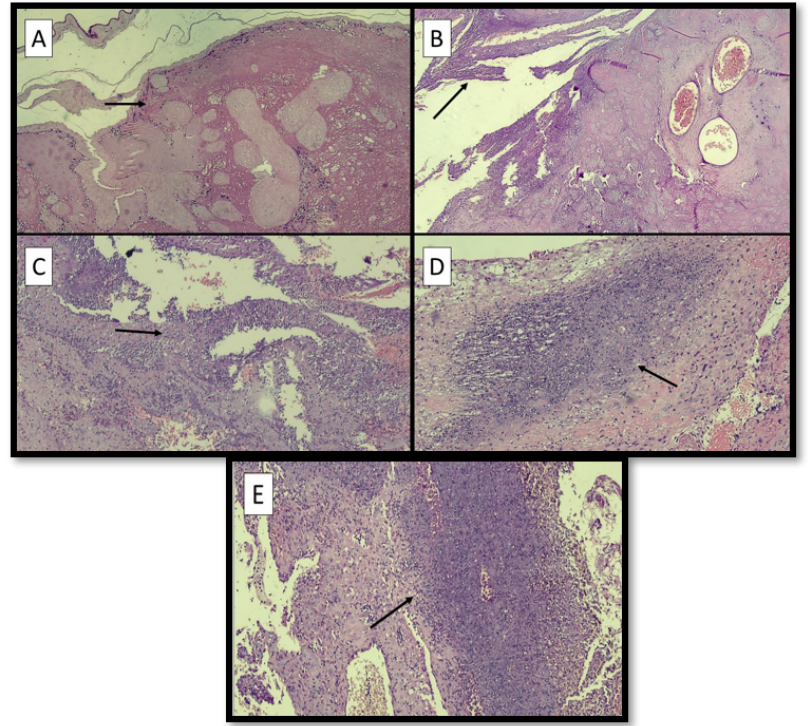
Figure 2A–E refers to examples of different sites of LN.